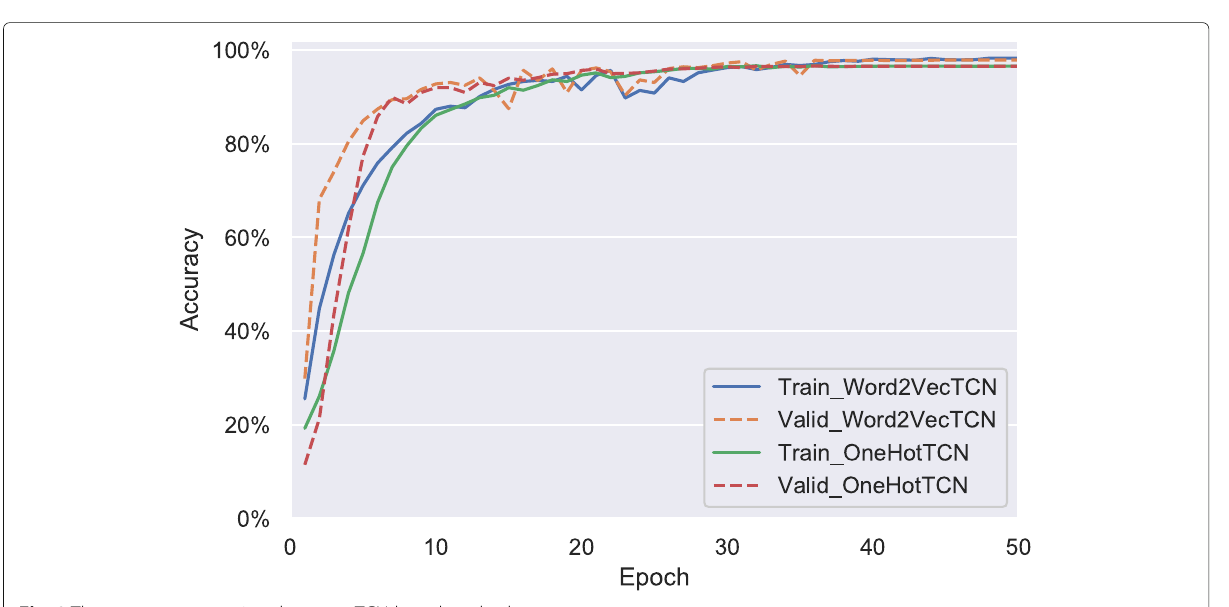
Fig. 8 The accuracy comparison between TCN-based